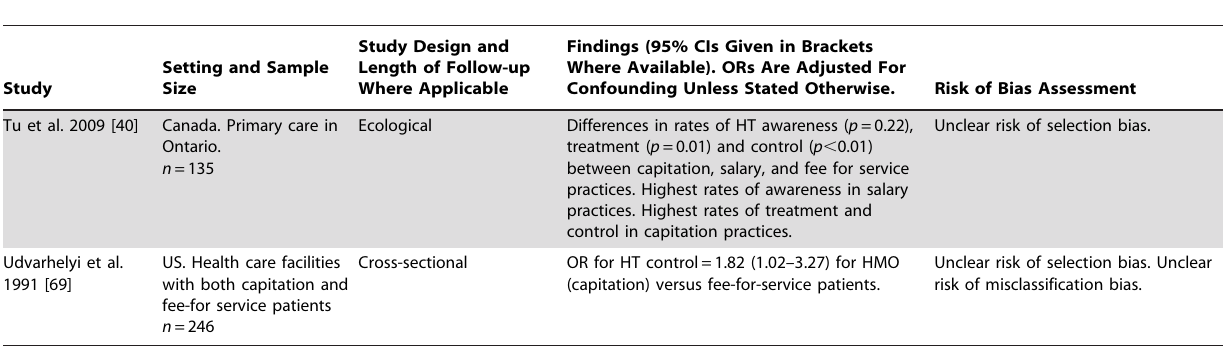
Table 5. Findings of quantitative studies examining the association of physician remuneration models with hypertension